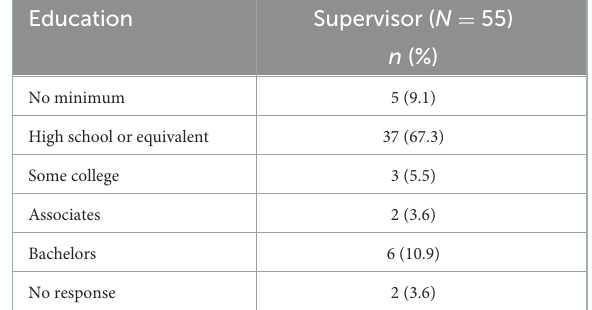
TABLE 1 Demographics of national sample of CHWs and CHW supervisors working with Medicaid managed care organizations. Variable